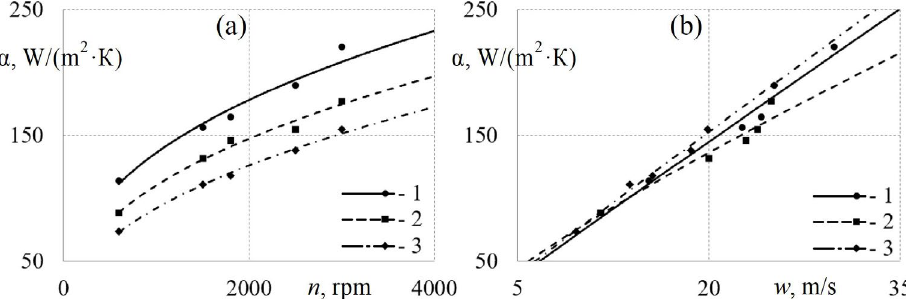
Figure 11. Dependences of the average heat transfer coefficient α on the crankshaft speed n ( a ) and the average flow rate w ( b ) in the intake system with channels of different diameters: 1— d = 26 mm; 2— d = 32 mm; 3— d = 40 mm.